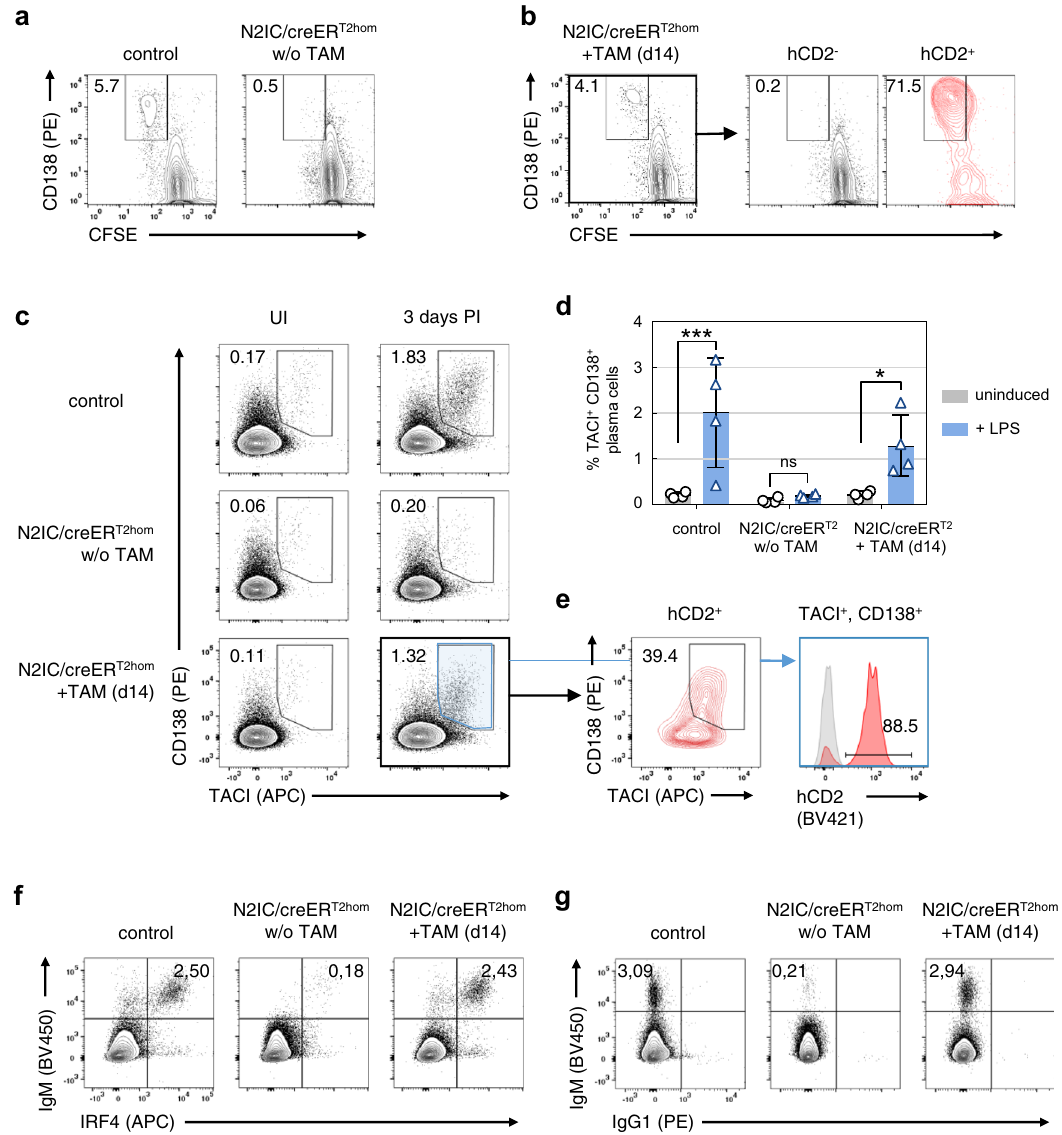
Fig. 3 Reconstituted MZB cells functionally resemble wildtype MZB cells. a , b Stimulation of puri fi ed B cells, with the indicated genotypes and treatment, with LPS for 48h in vitro (w/o TAM: without tamoxifen treatment; + TAM (14d): day 14 after tamoxifen treatment). a Plots are pre-gated on living singlets, plasmablasts are gated as CD138 + CFSE low cells. b Cells were gated on living singlets (left) and consecutively separated in hCD2 − (black) and hCD2 + (red) cells. FACS plots in a , b are representative for two independent experiments. c – e Plasmablast differentiation in vivo after immunization with NP-LPS: c fl ow cytometric analyses show the percentages of plasmablasts (CD138 + TACI + ) in the spleen of unimmunised (UI) and immunized control and N2IC/creER T2hom mice (3 days post immunization (PI) with NP-LPS). Cells were pregated on a large lymphocyte gate. d Summary and quanti fi cation of plasmablast percentages 3 days after NP-LPS immunization. Bar graph shows mean values and SD. Data points represent single mice from two independent experiments. *** p = 8.0E − 04; * p = 0.040 (two-way ANOVA, Sidak´s multiple comparisons test). e Additional analysis of splenocytes from TAM-treated N2IC/creER T2hom mice after immunization with NP-LPS: Indicated are the percentage of plasmablasts (CD138 + TACI + ) within hCD2 + cells and the percentage of hCD2 + cells in all TACI + CD138 + plasmablasts (red plot and histogram, respectively). Gray histogram: hCD2-staining of plasmablasts from immunized control animals (negative control). f , g Intracellular fl ow cytometric analysis of splenocytes from the immunized mice shown in ( c ). f Plasmablasts were identi fi ed as IRF4 high IgM high . g Separation of plasmablasts in IgM + and IgG1 + cells. FACS plots in c – e are representative for two individual experiments with n = 4 mice per